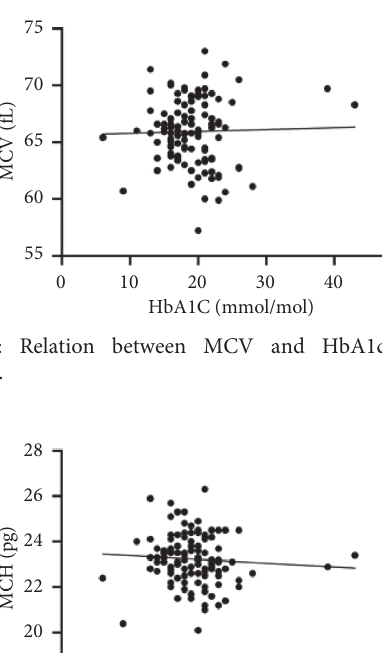
Figure 7: Relation between the red cell distribution width and HbA1c ( r � 0.038; p � 0 . 053).